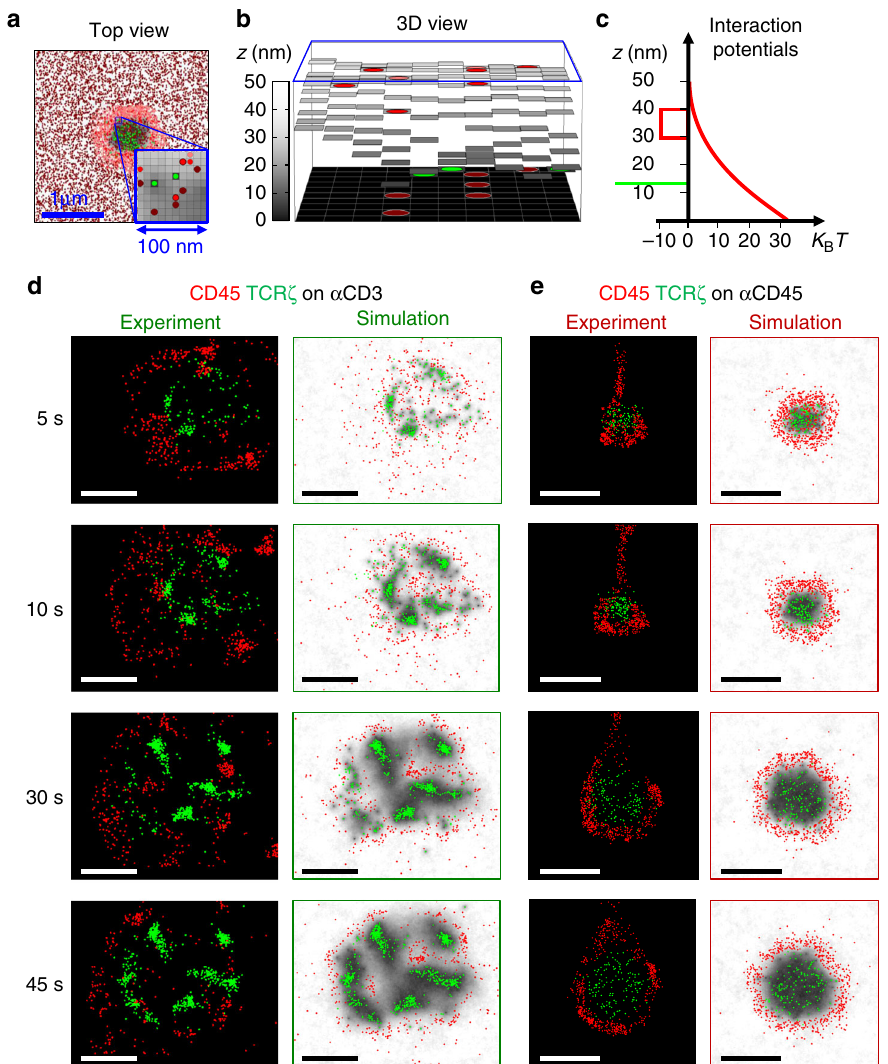
Fig. 4 Numerical modelling and hybrid simulations capture the KS at the tips of microvilli. A numerical model that captures the energetics of the plasma membranes (PM) of interacting T cell with an activating coverslip. a Top view of a representative simulated interface at t = 10 s. Dark red points show anti- CD45 ligands randomly distributed with density = 1000 molecules μ m − 2 . Red points show locations of CD45, light red points show locations of other glycoproteins (GP), namely CD43 and CD148. Green points show locations of TCRs. The inset shows an enlarged view of a 100 nm × 100 nm square. The three types of proteins and the dark red ligands are shown. The grey levels mark the height of the membrane from 0 to 50 nm. b 3D in scale view of the inset in a . Patterning of the height of the PM is illustrated in the z axis due to thermal fl uctuations and molecular interactions. c The potential energy ( V ) of molecular interactions at the PMs of T cell and APC (or activating coverslip), as a function of their local separation ( z ij ). The thin green rectangle is effectively in fi nite in length as the membrane at the TCRs is forced to be z = 13 nm. The red rectangle between 30 and 40 nm is the interaction potential of the CD45 and anti-CD45. The red line describes the repulsive energy of the CD45 and the other glycoprotein (GP; CD43 and CD148) molecules. d (left) Experimental SMLM results, as shown in Fig. 2a, of newly forming contacts of E6.1 cells spreading on anti-CD3 ε -coated coverslips. Green points are TCRs and red points are CD45. Frames are taken at 5, 10, 30 and 45 s. (right) Simulated results. In the anti-CD3 simulations we did not use ‘ ligands ’ but instead forced the membrane at the locations of the TCRs to a height of 13 nm. e (left) Experimental SMLM results, as shown in Fig. 2a, of newly forming contacts of E6.1 cells spreading on anti-CD45-coated coverslips. (right) Simulated results. The simulation ran with ligand density = 1000 molecules μ m − 2 , rigidity = 25 K B T and TCR – CD45 maximal apparent separation = 200 nm. The scale bar is 1 μ